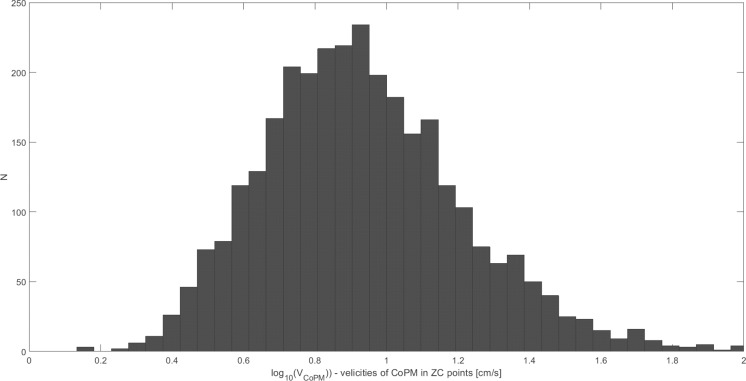
The exemplary close to normal distribution of the variable LVCoPM = mean(log10
vCoPMZC).vCoPMZC denotes the value of vCoPM in the given ZC point and LVCoPM denotes the mean over all the ZC points in the given signal. Values for all patients and their registration conditions are presented.